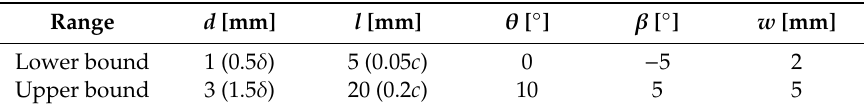
Table 3. Range of Table 3. Range of variables.